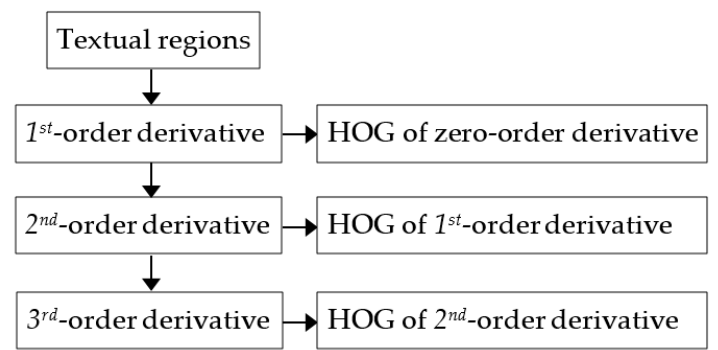
Figure 4. The extraction of structural features of textual regions.